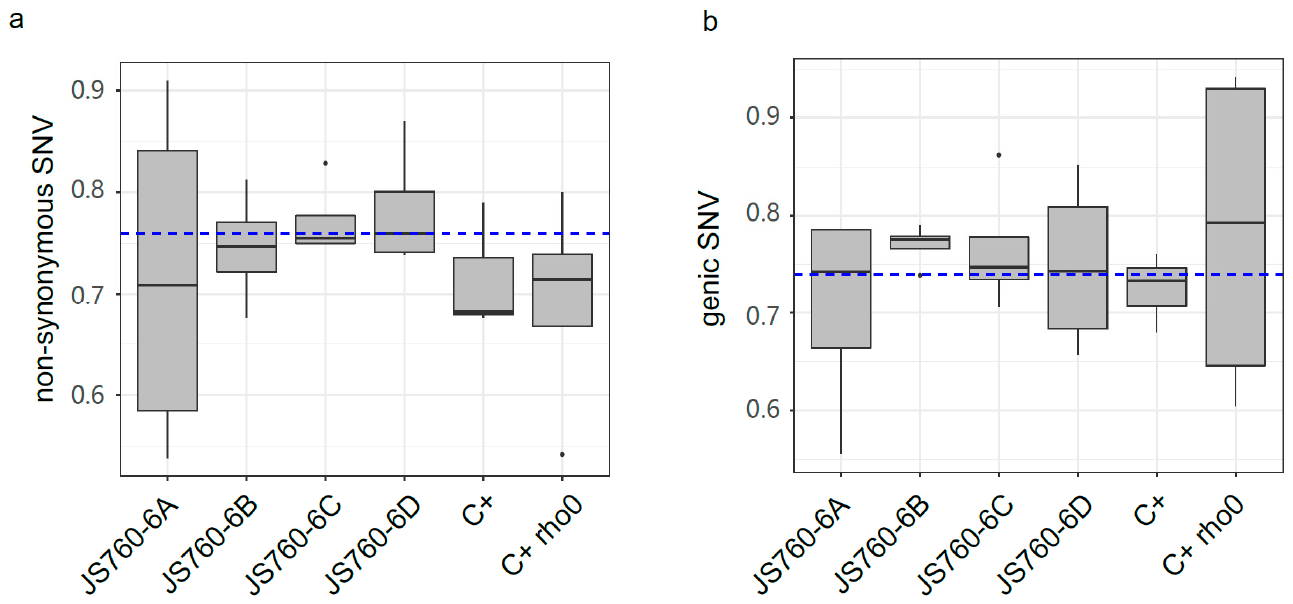
Figure 3. Non-synonymous and genic SNVs of the six strains. ( a ) Proportion of non-synonymous SNVs. ( b ) Proportion of genic SNVs. The blue lines in panels a and b represent the expected values for the proportion of non-synonymous SNVs and genic SNVs, respectively, under the neutral evolution model. The genotypes of the six strains are as follows: JS760-6A ( MRPL25 + atp3 G348T ), JS760-6B ( mrpl25 ∆ ATP3 + ), JS760-6C ( MRPL25 + ATP3 + ), JS760-6D ( mrpl25 ∆ atp3 G348T ), C+ (positive control), C+ rho0 (negative control).